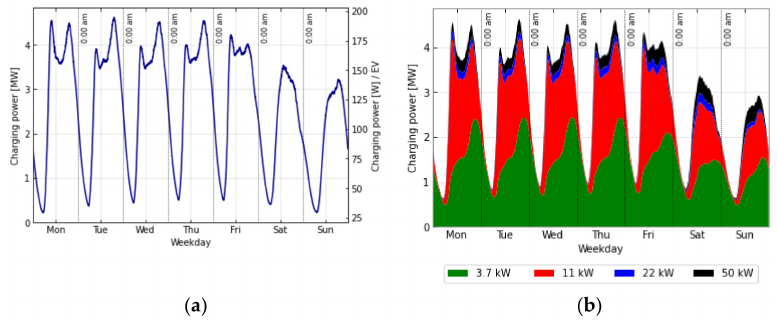
Figure 3. ( a ) Average power profile, aggregated (left axis) and proportional (right axis); ( b ) Average charging profile differentiated by the charging power